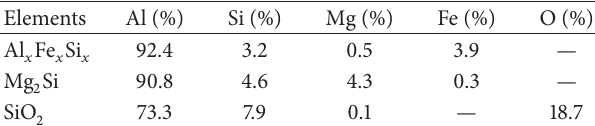
Table 4: Precipitations of the aluminum alloy.